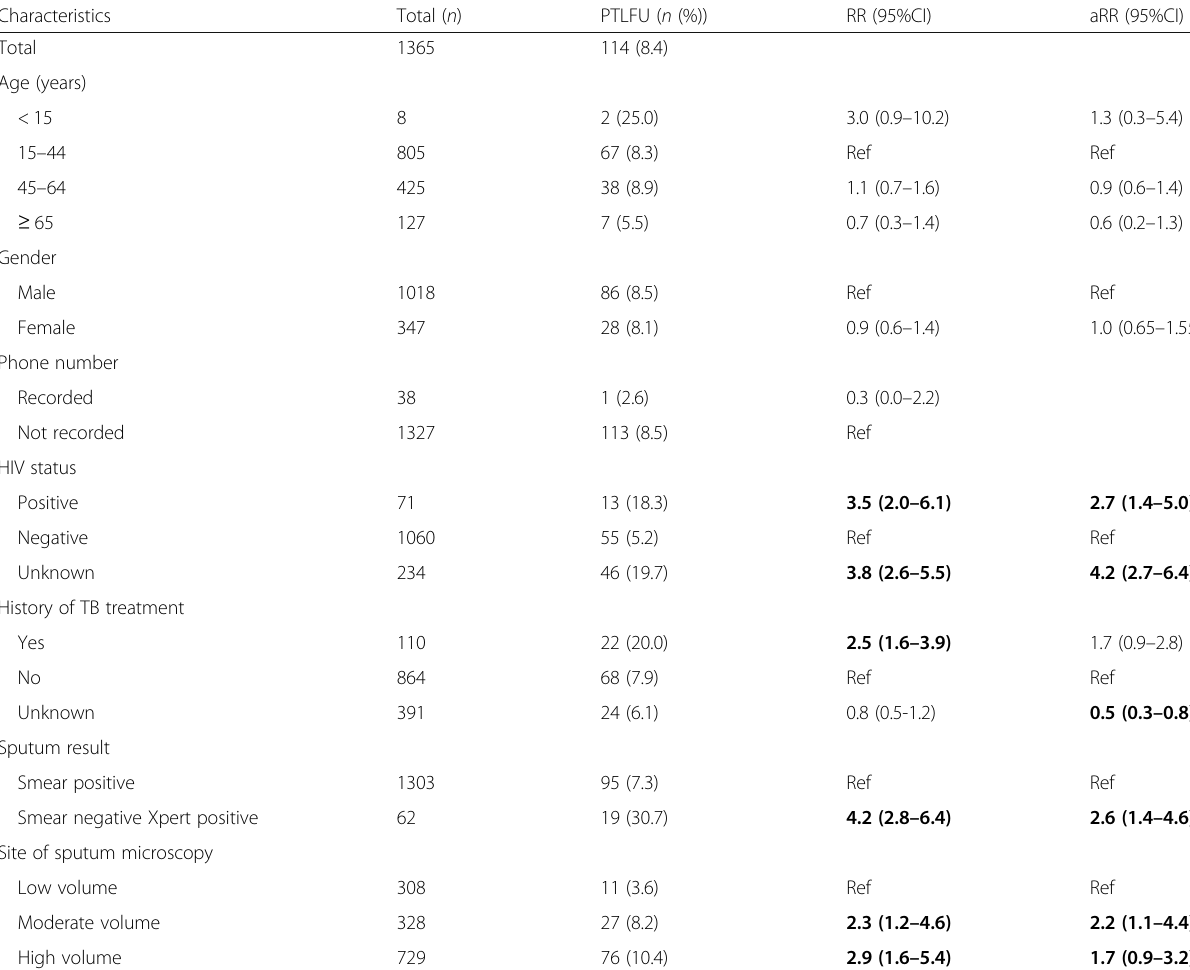
Table 2 Factors associated with pre-treatment loss to follow-up among bacteriologically confirmed TB patients diagnosed in 21 township health centres of the Mandalay Region of Myanmar between January and June 2017